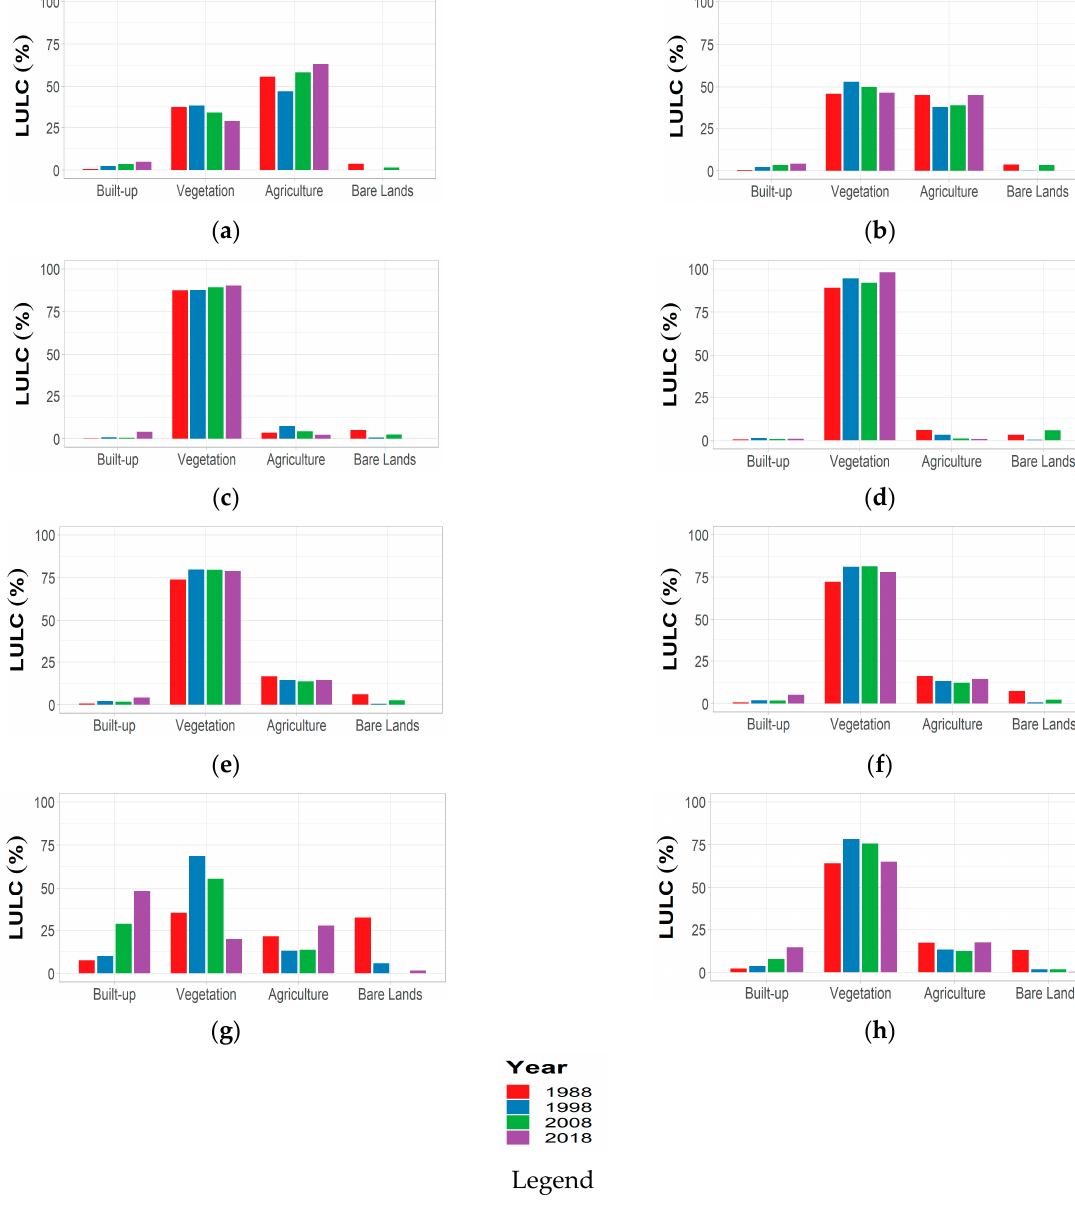
Figure 3. Percentage area of each LULC: (a) Norwood subbasin; (b) Kithulgala subbasin; ( c ) Holombuwa subbasin; ( d ) Deraniyagala subbasin; ( e ) Glencourse subbasin; ( f ) Hanwella subbasin; ( g ) Lower Kelani subbasin; ( h ) entire Kelani basin.